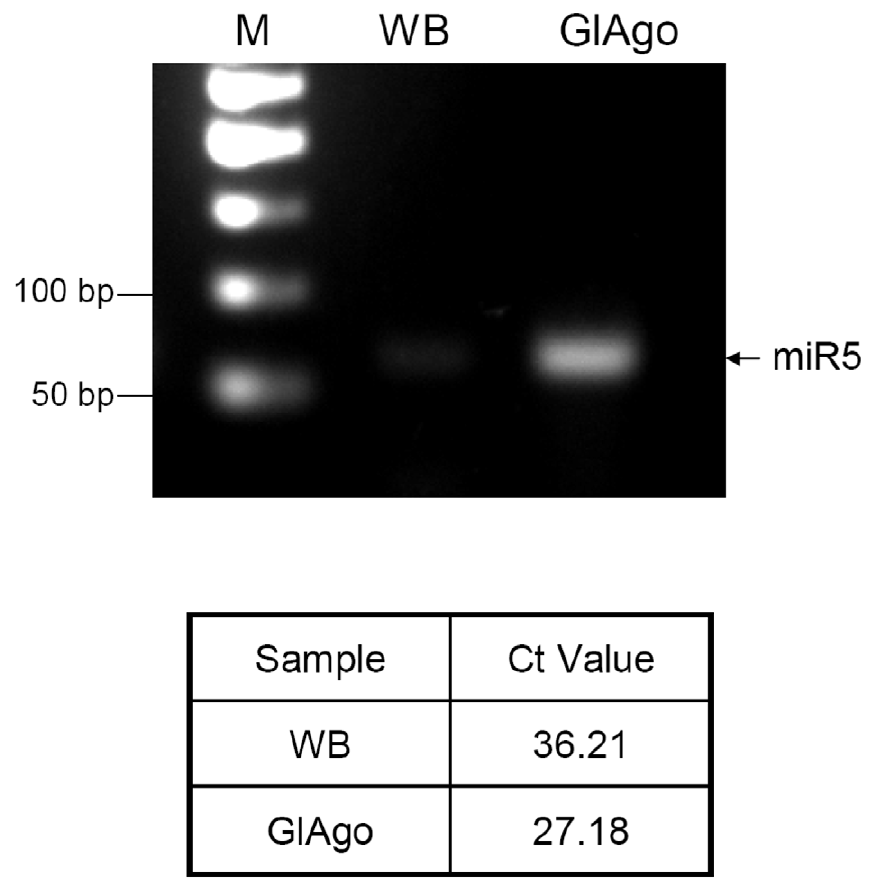
Figure 5. miR5 was co-immunoprecipitated with GlAgo. The , 26 nt RNA band co-immunoprecipitated with 3 6 HA GlAgo [21] was analyzed by RT-qPCR using TaqMan probe specific for miR5. GlAgo: RNA template extracted from the immunoprecipitate of 3 6 HA GlAgo expressing cells. WB: RNA template extracted from the immunoprecipitate of control cells. The qPCR products were run on a 2% agarose gel. The specific band at , 70 bp (26 nts plus the linker) showed miR5 co-immunoprecipitated with 3 6 HA GlAgo ( upper panel ). The Ct values between the two samples differed by about 9 cycles, suggesting that miR5 bound specifically to 3 6 HA GlAgo and became enriched in the immonoprecipitate ( lower panel ).